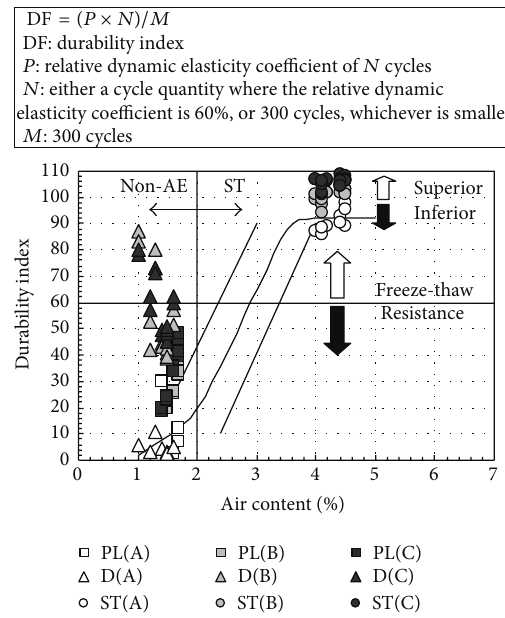
Figure 9: Relation between water-cement ratio and carbonation velocity coefficient (initial curing methods I).